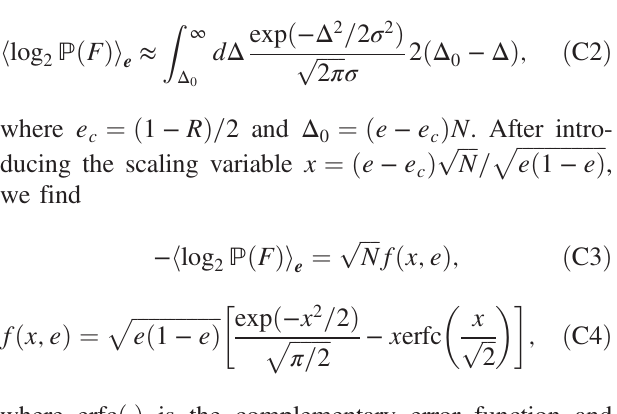
at large N . We take c